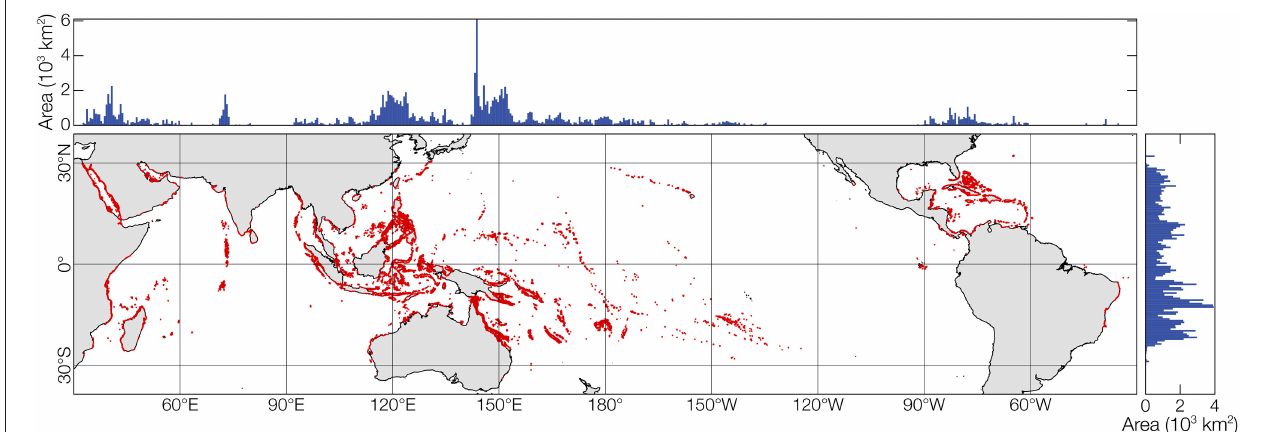
FIGURE 1 | Global distribution of coral reefs. Summaries of latitudinal and longitudinal extents of coral reefs are shown above and to the right. Coral reefs occupy 250,000–600,000 km 2 (depending on the definition of “coral reef”), or 0.05–0.15% of the global ocean, but they are scattered across 230,000,000 km 2 of the earth’s surface. Only 0.01–0.1% of the world’s reef area has been quantitatively assessed. Global reef distribution from UNEP-WCMC et al. (2018).